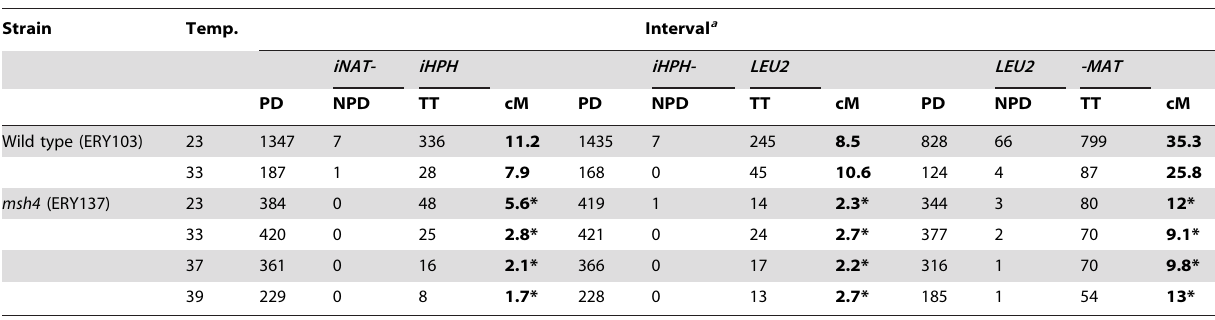
Table 3. Genetic map distances in wild-type and msh4 strains.